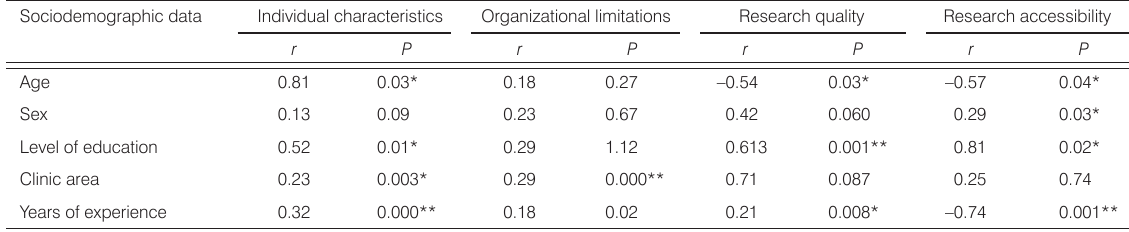
Table 7. Correlation between EBP obstacles and nurses’ sociodemographic data ( N =154).